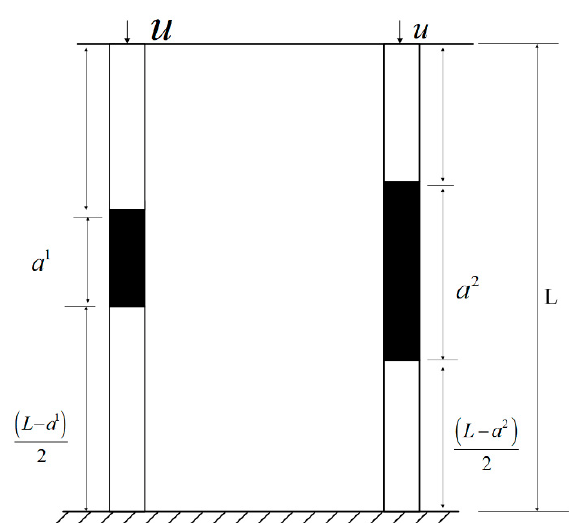
Figure 4. A coupled one-dimensional (1-D) model: two linearly elastic and nonhomogeneous bars connected by two rigid plates